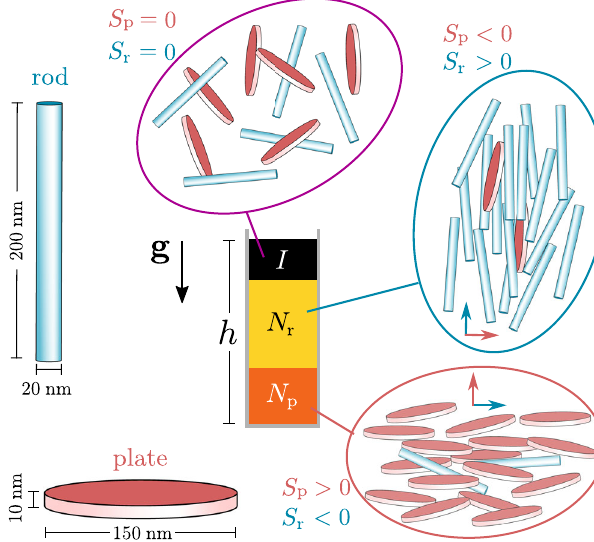
Fig. 1 Model. Schematics of colloidal rods (blue) and plates (red), together with schematics of the particles in the isotropic ( I ), the nematic rod-rich ( N r ) and the nematic plate-rich ( N p ) layers that appear in a cuvette of height h under the gravitational fi eld g . The blue and red arrows indicate the nematic director for rods and plates, respectively. The sign of the uniaxial order parameter of plates S p and rods S r in each phase is also indicated (the order parameter is calculated with respect to the director of the dominant species in each